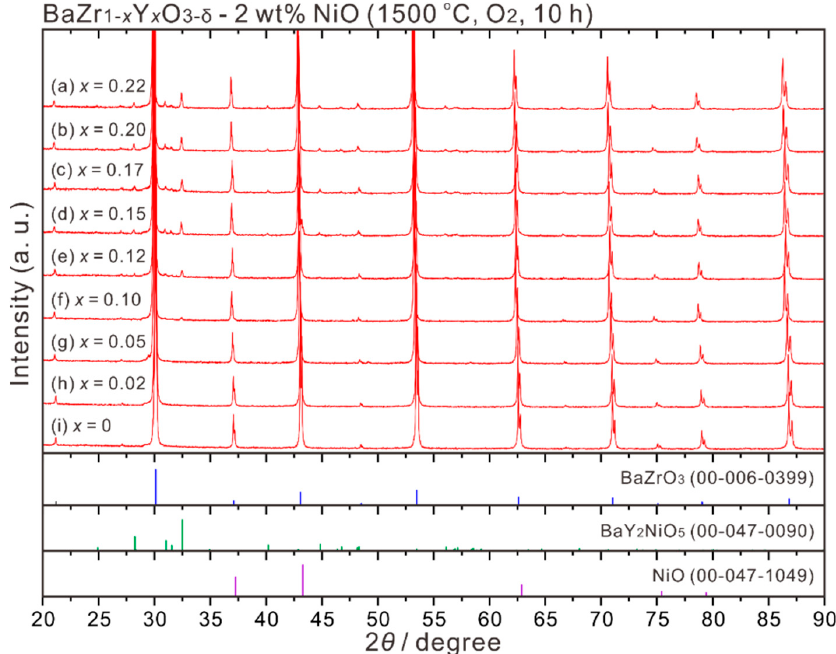
Figure 7. Powder XRD patterns of the BaZr 1 − x Y x O 3 − δ -2 wt % NiO ( x = 0, 0.02, 0.05, 0.1, 0.12, 0.15, 0.17, 0.20, 0.22) samples, which were sintered at 1500 °C in oxygen for 10 h.